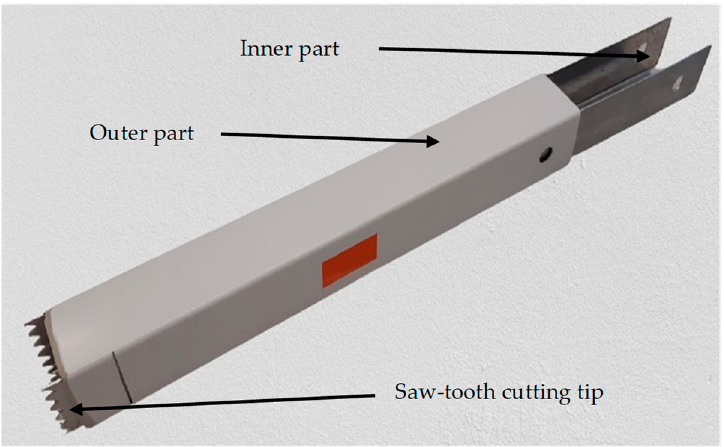
Figure 2. Snow core sampler.